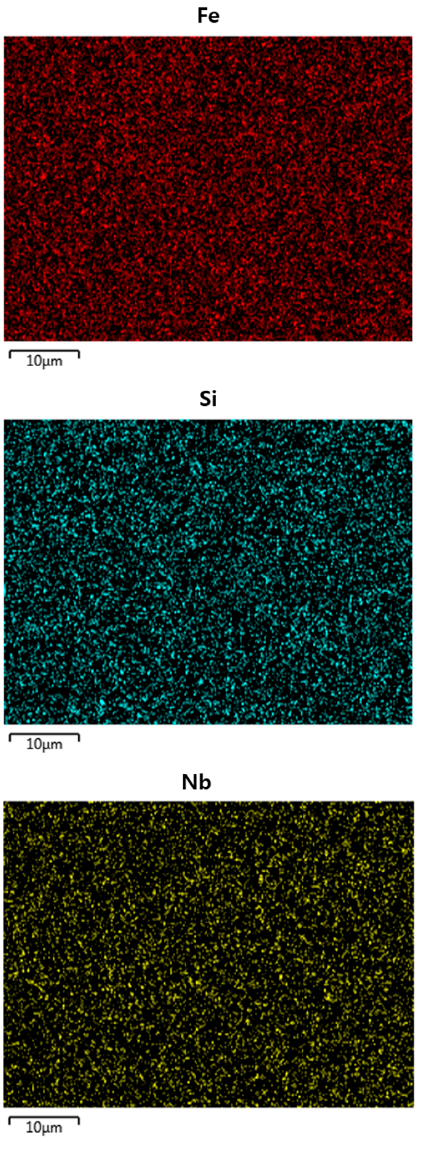
Figure 1. SEM-EDS spectrum for Fe, Co, B, Si, and Nb elements for the as-spun (Fe x Co 1 − x ) 72 B 19.2 Si 4.8 Nb 4 ( x = 0.7)